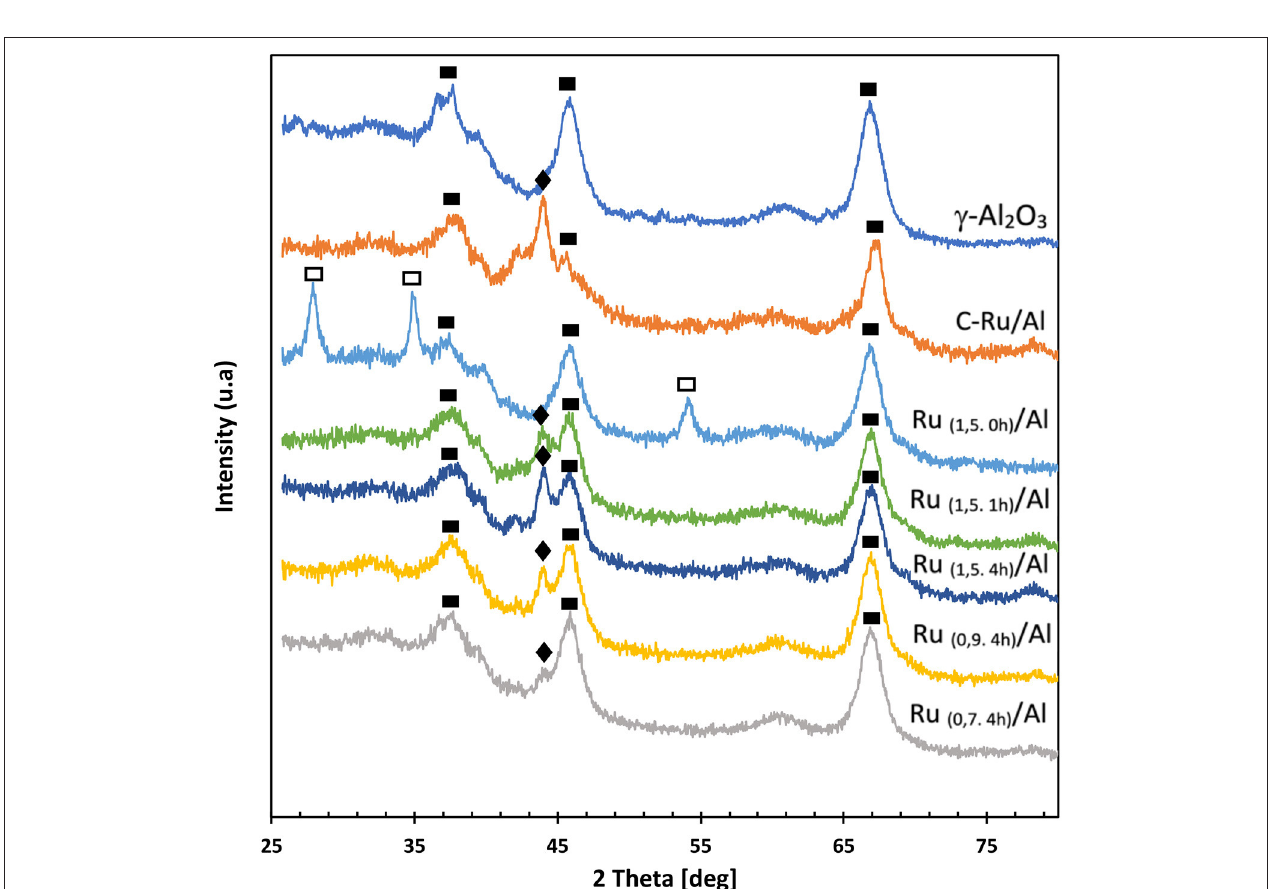
FIGURE 3 | X-ray diffraction patterns supported Ru catalysts. ( (cid:4) ) Al = γ -Al 2 O 3 ; ( (cid:3) ) RuO 2 ; ( (cid:7) ) Ru.